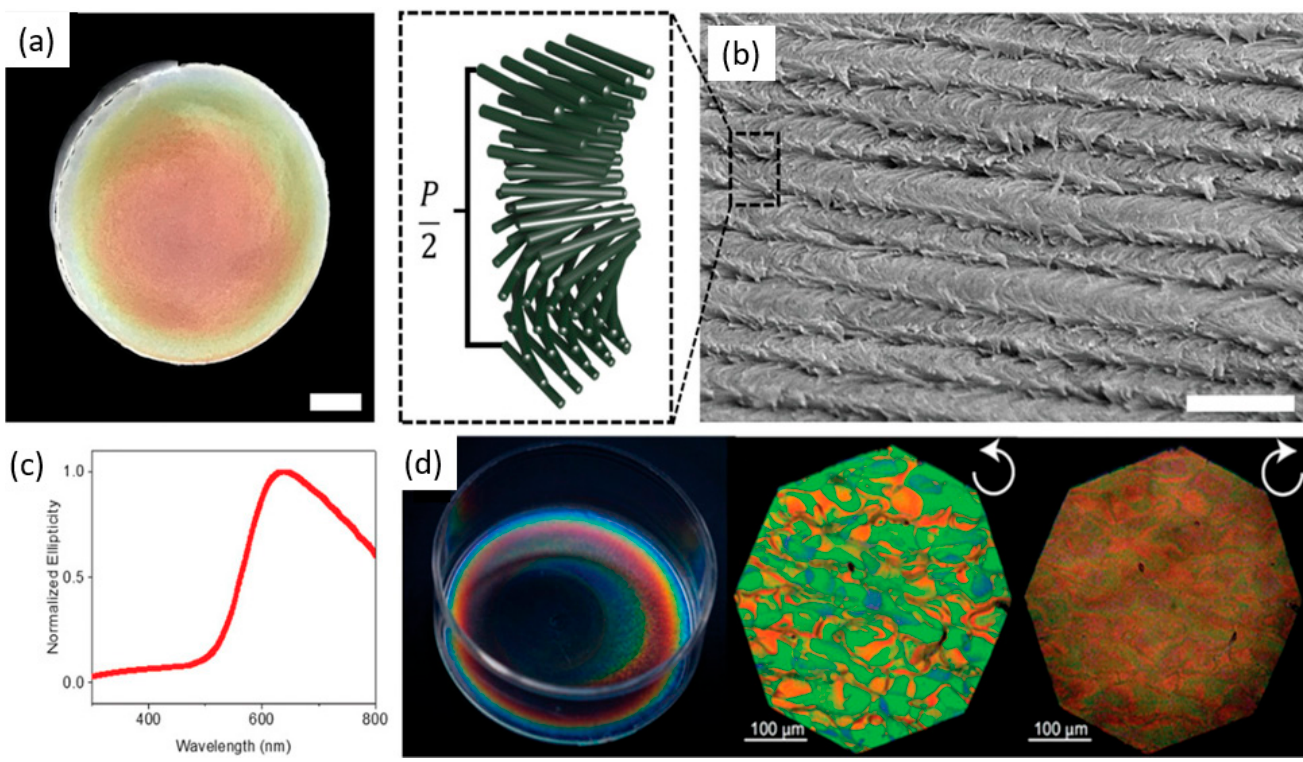
Figure 8. ( a ) A cholesteric CNC film’s structure and optical characteristics. ( b ) Photograph of chiral nematic CNC film displaying structural color iridescence. ( c ) Scanning electron micrograph of CNC in a film with a helical twist. The helical pitch is schematically represented in the dashed-line inset (P). ( d ) A typical cholesteric CNC film’s circular dichroism spectrum. Natural light (left), left-handed circularly polarized light (center), and right-handed circularly polarized light (right) views of chiral nematic CNC film (right). Reproduced from [81].